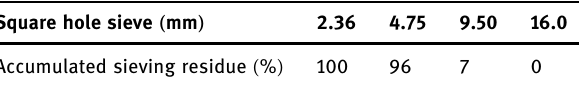
Table 4: Particle size distribution of gravel ( 5 – 10 mm ) Square hole sieve ( mm )